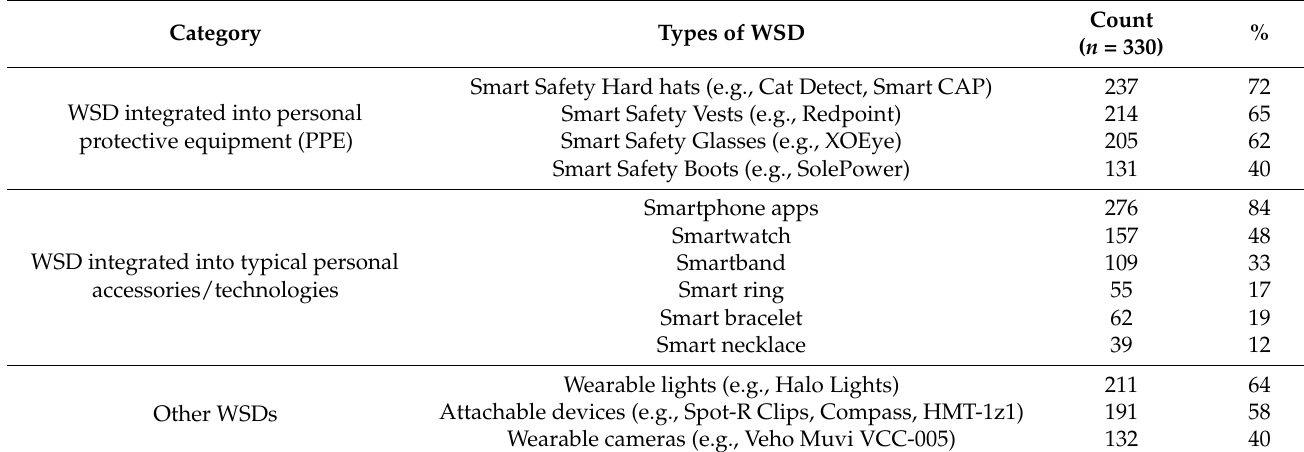
Table 3. WSDs used on construction